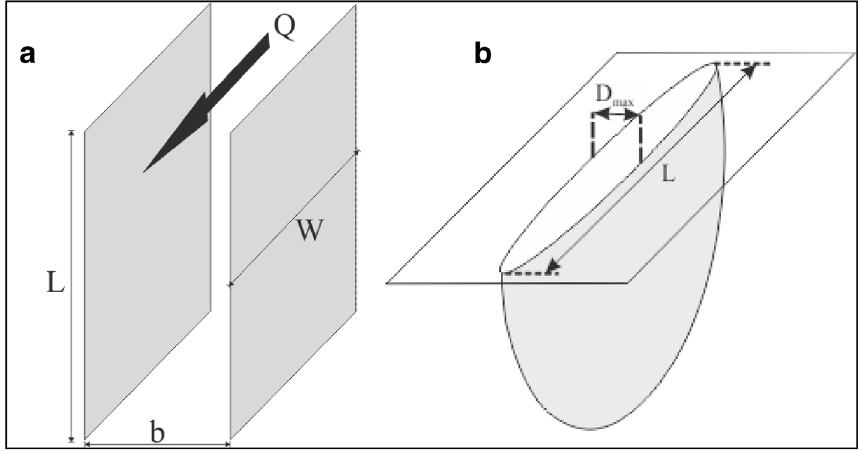
Fig. 2 a Schematic diagram (modified after Klimczak et al. 2010) of fluid flow ( Q ) through parallel plates with length L , breadth W , and constant aperture width b . ‘ b ’ is equivalent to D avg . b Schematic diagram of an ideal isolated fracture with an elliptical opening profile having Length L and maximum aperture width D